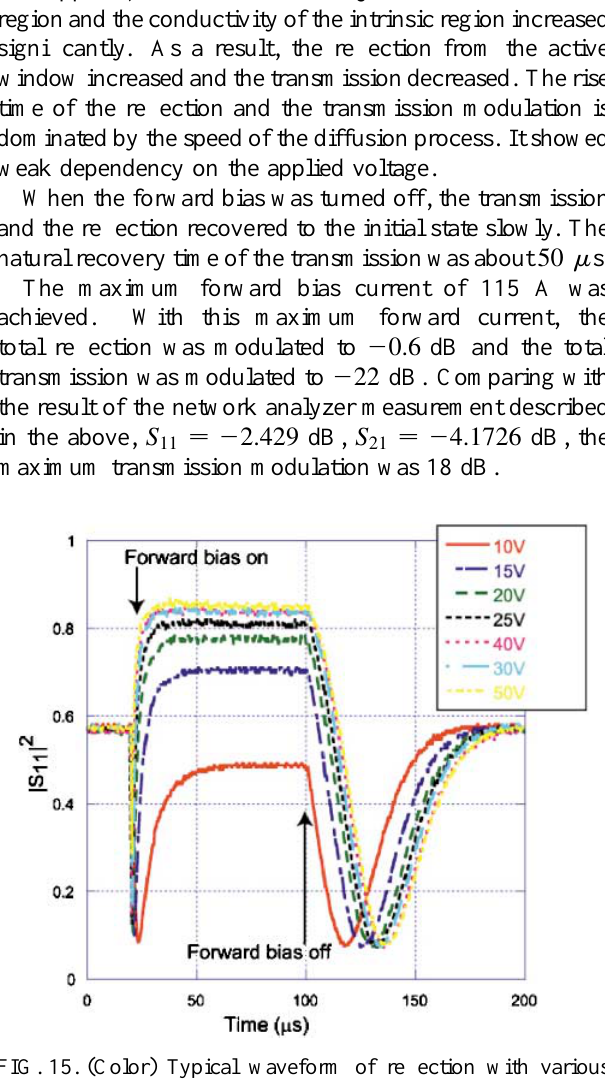
FIG. 14. Schematic diagram of the low power measurement.